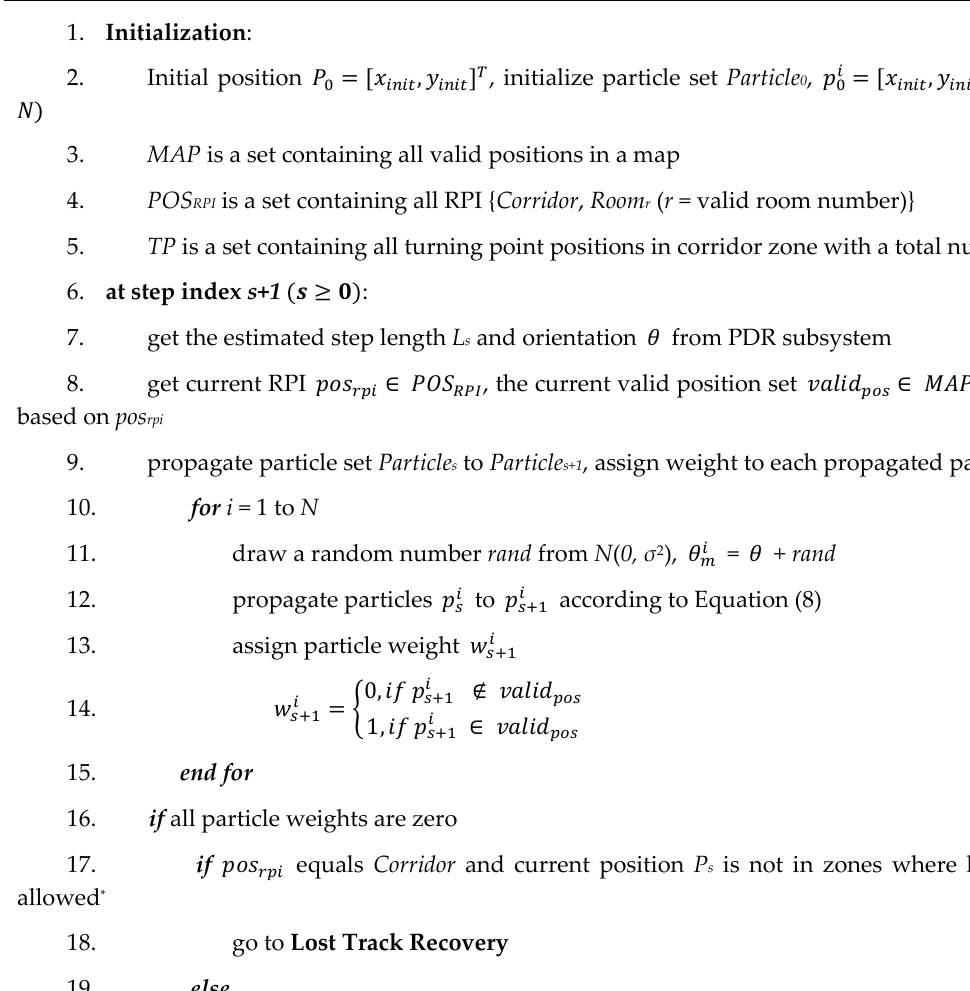
Algorithm 2 Particle Filter Map Matching for Pedestrian